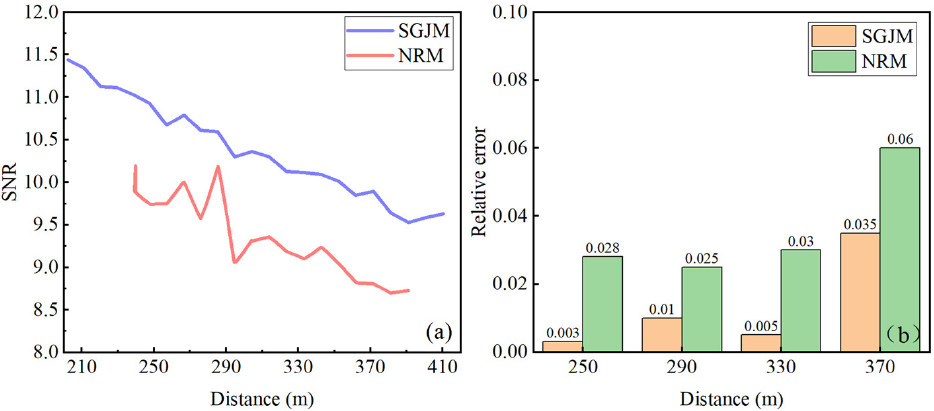
Figure 12. Comparison of two methods, SNR and RE: ( a ) SNR; ( b ) RE.